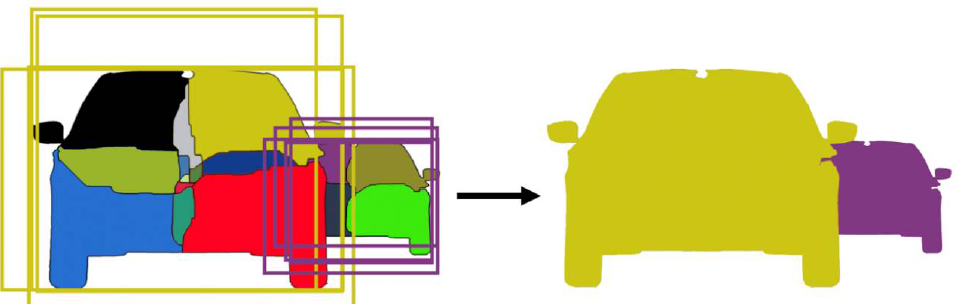
Figure 12. The final result, obtained by labeling the regions with the rectangle labels, then transferring the region labels to the individual pixels.